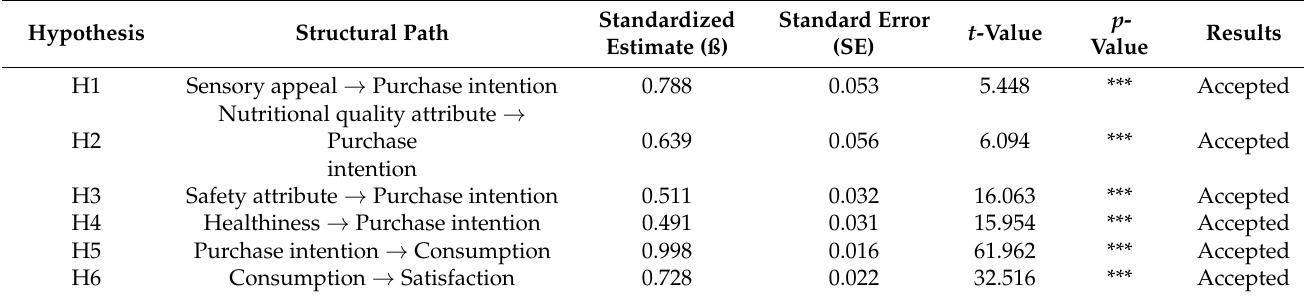
Figure 2. Structural equation modeling to assess the role of product determinants on purchase intention, consumption, and satisfaction of consumers towards convenience food. Structural model fit indices: CFI: 0.913; TLI: 0.906; GFI: 0.903; RMSEA: 0.073; SRMR: 0.075; χ 2/df = 3.91. Table 4. Structural model results to examine the association of between product determinants and purchase intention, consumption, and satisfaction for convenience